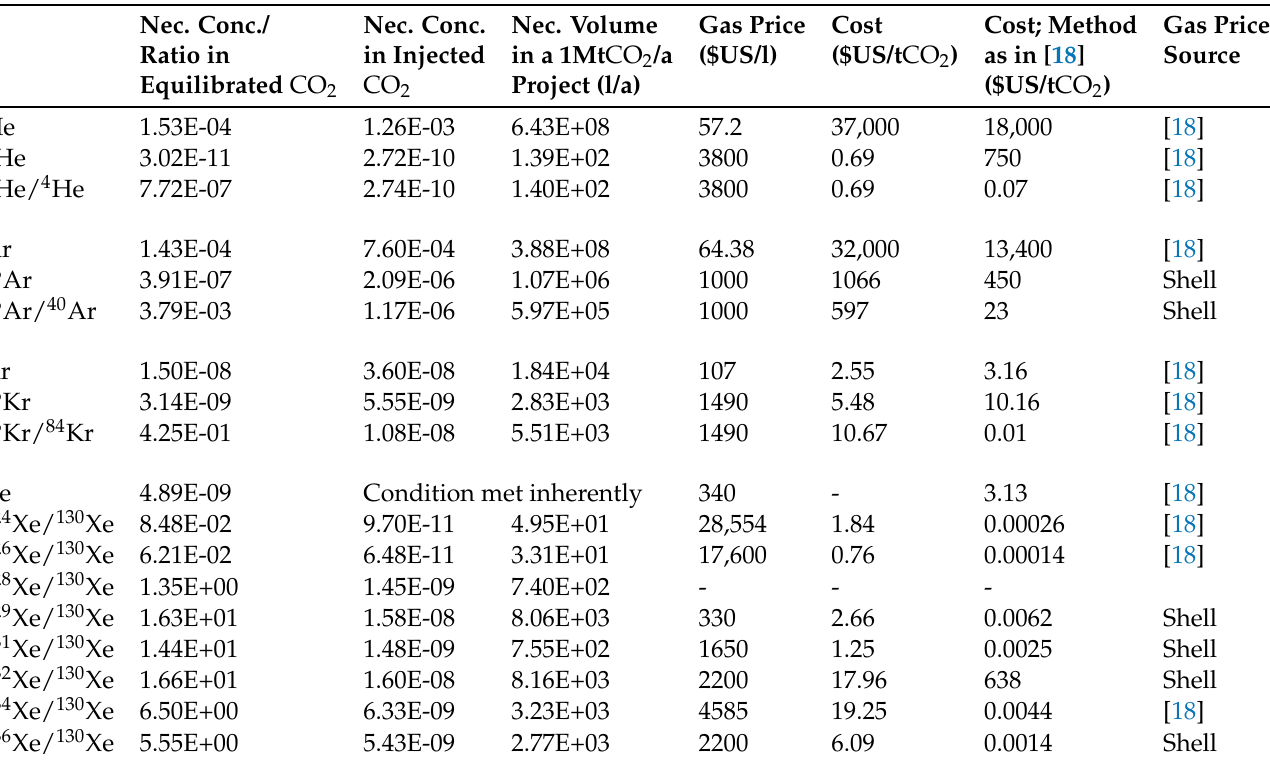
Table 4. Necessary noble gas concentrations in cm 3 /cm 3 and isotopic ratios to fulfill the detection condition described STP STP in Section 2.3 both in the equilibrated and the injected CO 2 . For isotopic ratios, calculations are conducted for the isotope in the numerator of the ratio. As shown in Section 3.1, the distinctiveness condition for Xe and its isotopes is inherently met in our calculations. For Xe ratios, a concentration of 1.50E-11 130 Xe inherent in the injected CO 2 is assumed. The volume is calculated for 1MtCO 2 /a storage project, and the associated cost for a tracer addition is derived. For comparability, the cost is additionally derived with the method in [18] and gas prices as in [18], where applicable. Exchange rate used for prices in [18]: £ = 1.3 ·